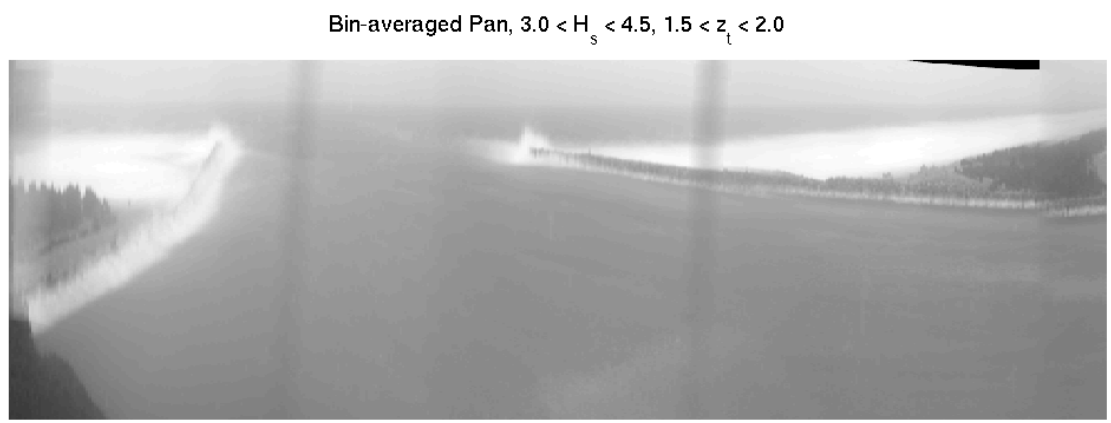
Figure 22. Bin-averaged “brightest” pan showing that large breaking occurs anomalously near the tip of the north jetty, usually within the seaward-most 100 m. In this example, the splash height is about 3.28 times the jetty